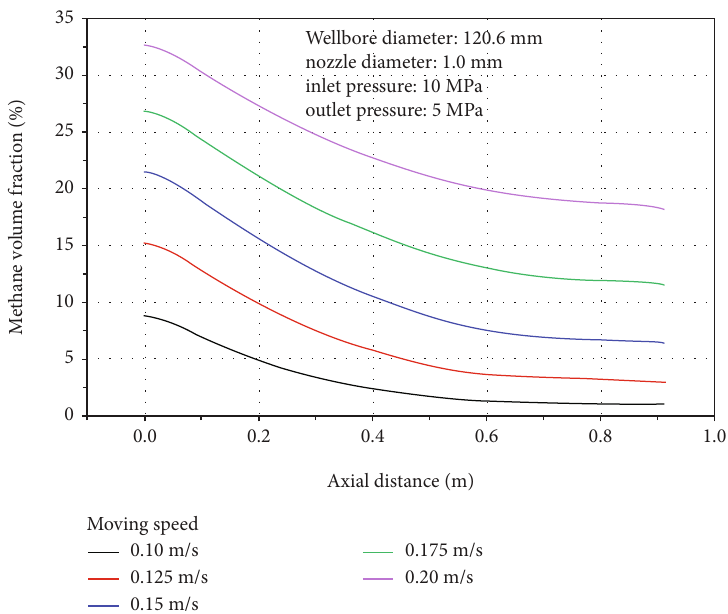
Figure 9: The e ff ect of nozzle moving speed on the distribution of methane components in wellbore.